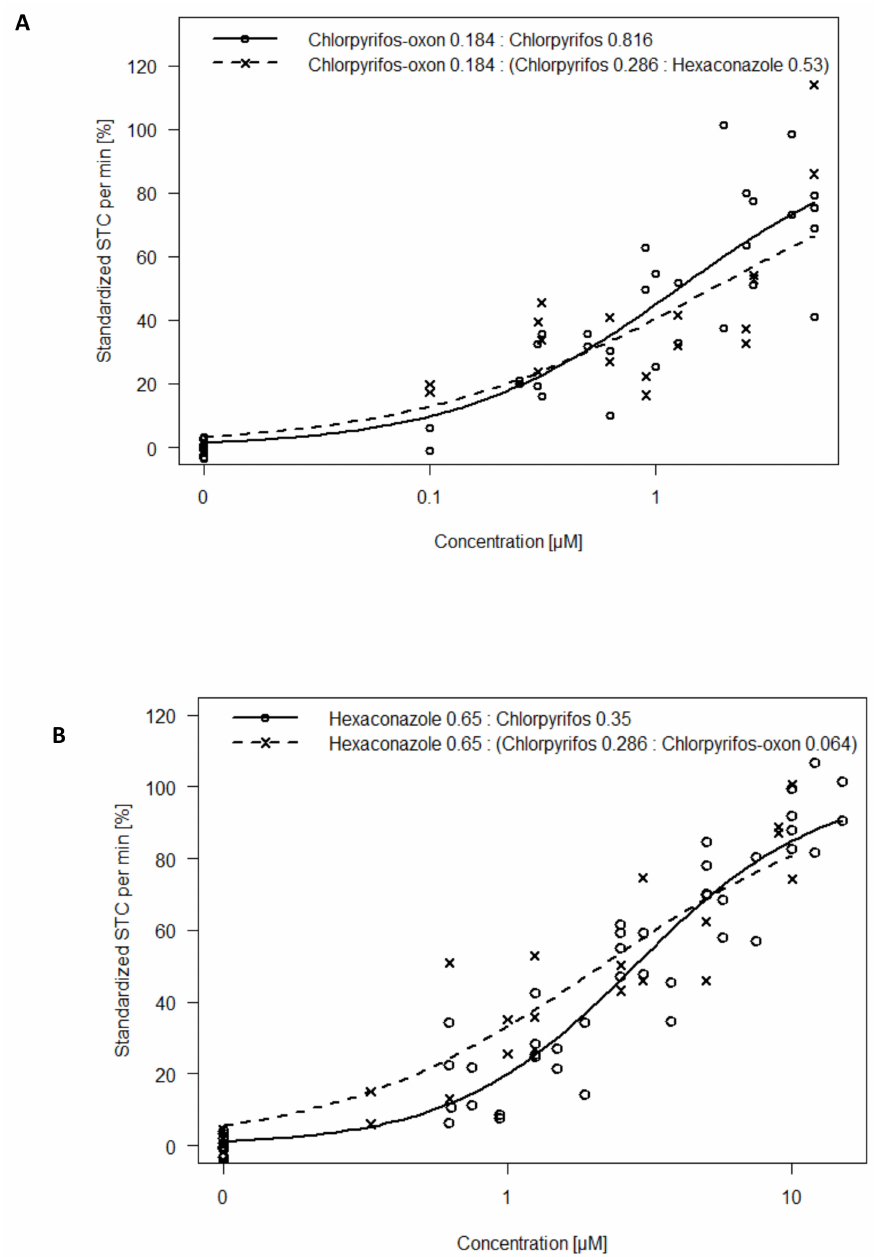
Figure 5. A ternary mixture is used to simulate a binary mixture by replacing a portion of one of the binary components with an equitoxic proportion of another substance: ( A ) Concentration– response curves for Hyperactive Mixture A containing chlorpyrifos-oxon and chlorpyrifos. Portions of chlorpyrifos were replaced with hexaconazole; ( B ) Concentration–response curves for Hyperactive Mixture B containing hexaconazole and chlorpyrifos. Portions of chlorpyrifos were replaced with